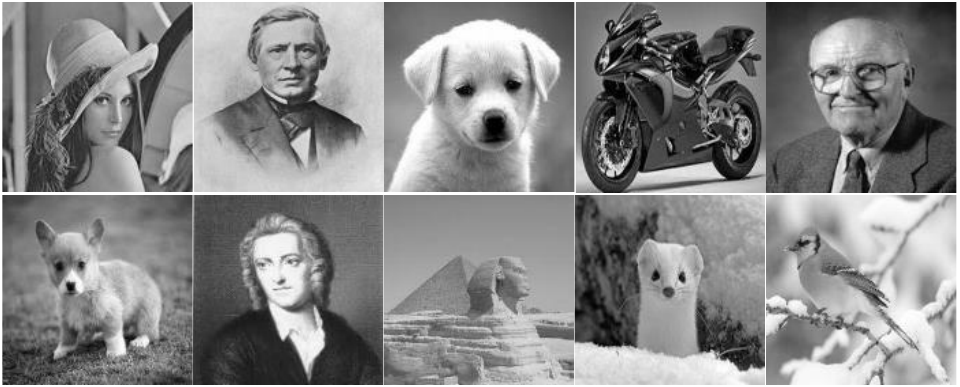
Figure 4. The 10 grayscale images used for testing. Each image was first converted from the size of 32 × 32 pixels to a vector with the size of 1 × 1024 pixels. Each pixel was then digitized by 4 bits [14,15]. Each 4 bit pixel a i (cid:104) 0 : 3 (cid:105) of one image was stored to four cross-points in four columns that had the weights of 8, 4, 2, and 1 for output calculating. All 10 images were stored to 10 groups with four columns each in the arrays ( M + , M − ) as patterns for recognizing an input vector. The block diagrams of the crossbar architectures for recognizing images are shown in Figure